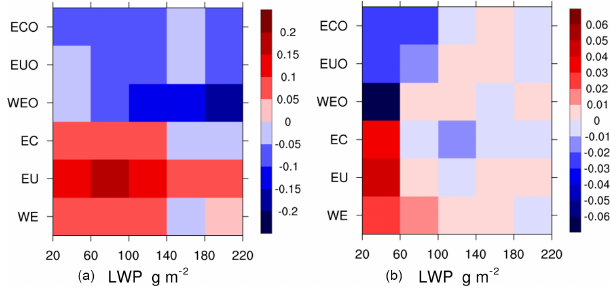
Figure 2. The computed slopes of (a) CER versus aerosol loading (AOD for land, AI for ocean) (Ma et al., 2018) and (b) LWP versus aerosol loading on a log–log scale over six regions, in which data are stratified according to